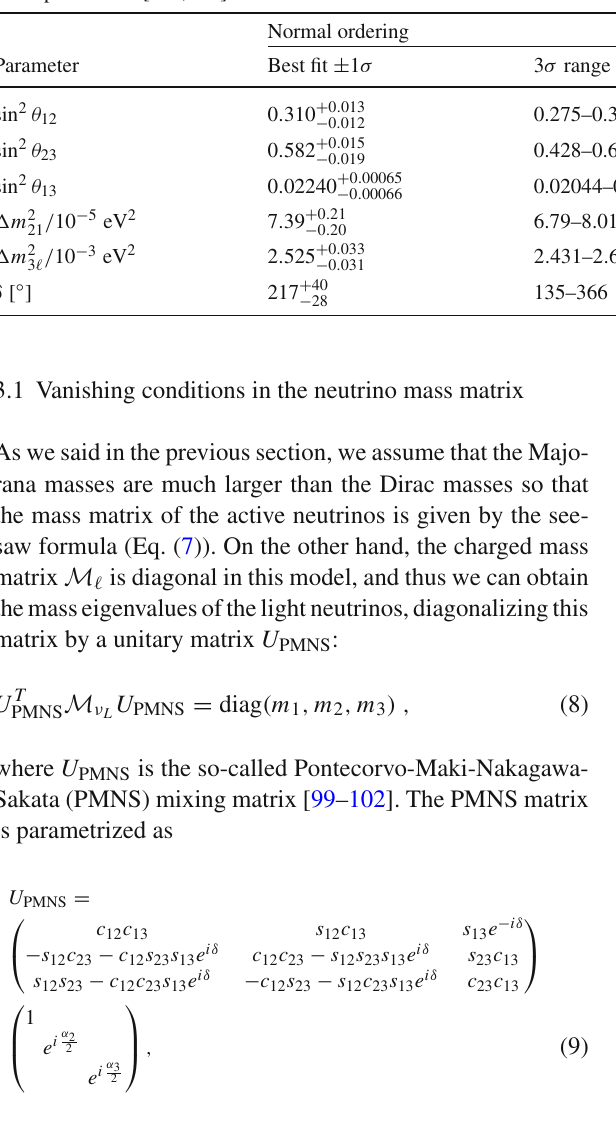
Table4 Valuesfortheneutrinooscillationparametersweuseinthispaper.Wetakethemfromthe NuFIT v4.0 resultwiththeSuper-Kamiokande atmospheric data